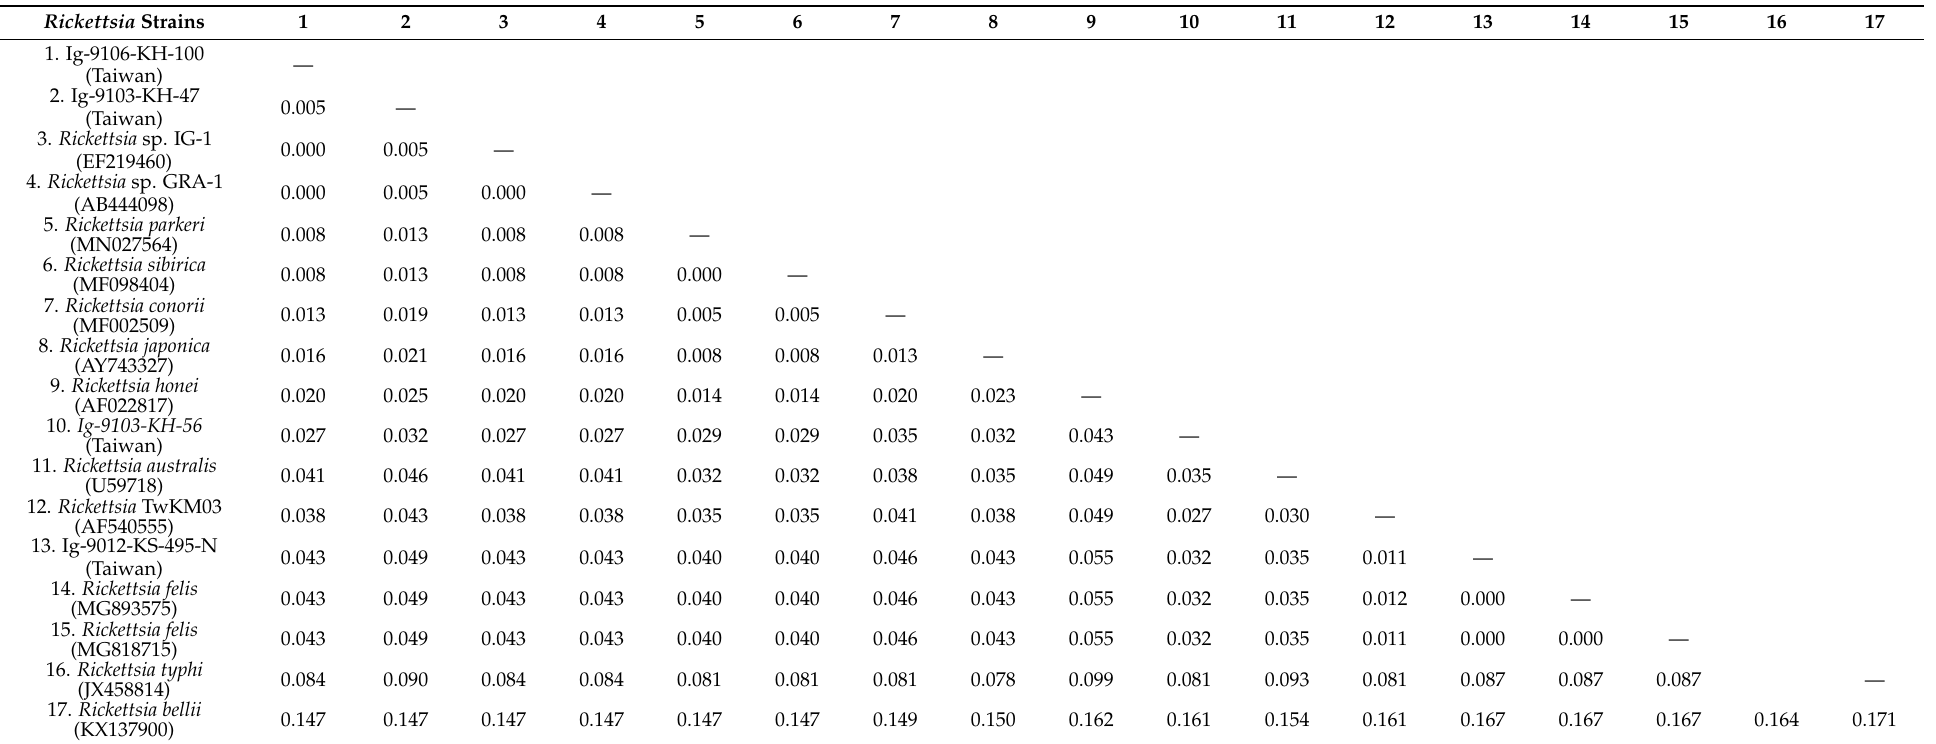
Table 3. Intra- and inter-species analysis of genetic distance values a based on the gltA gene sequences between Rickettsia strains of Taiwan and other strains of Rickettsia documented in